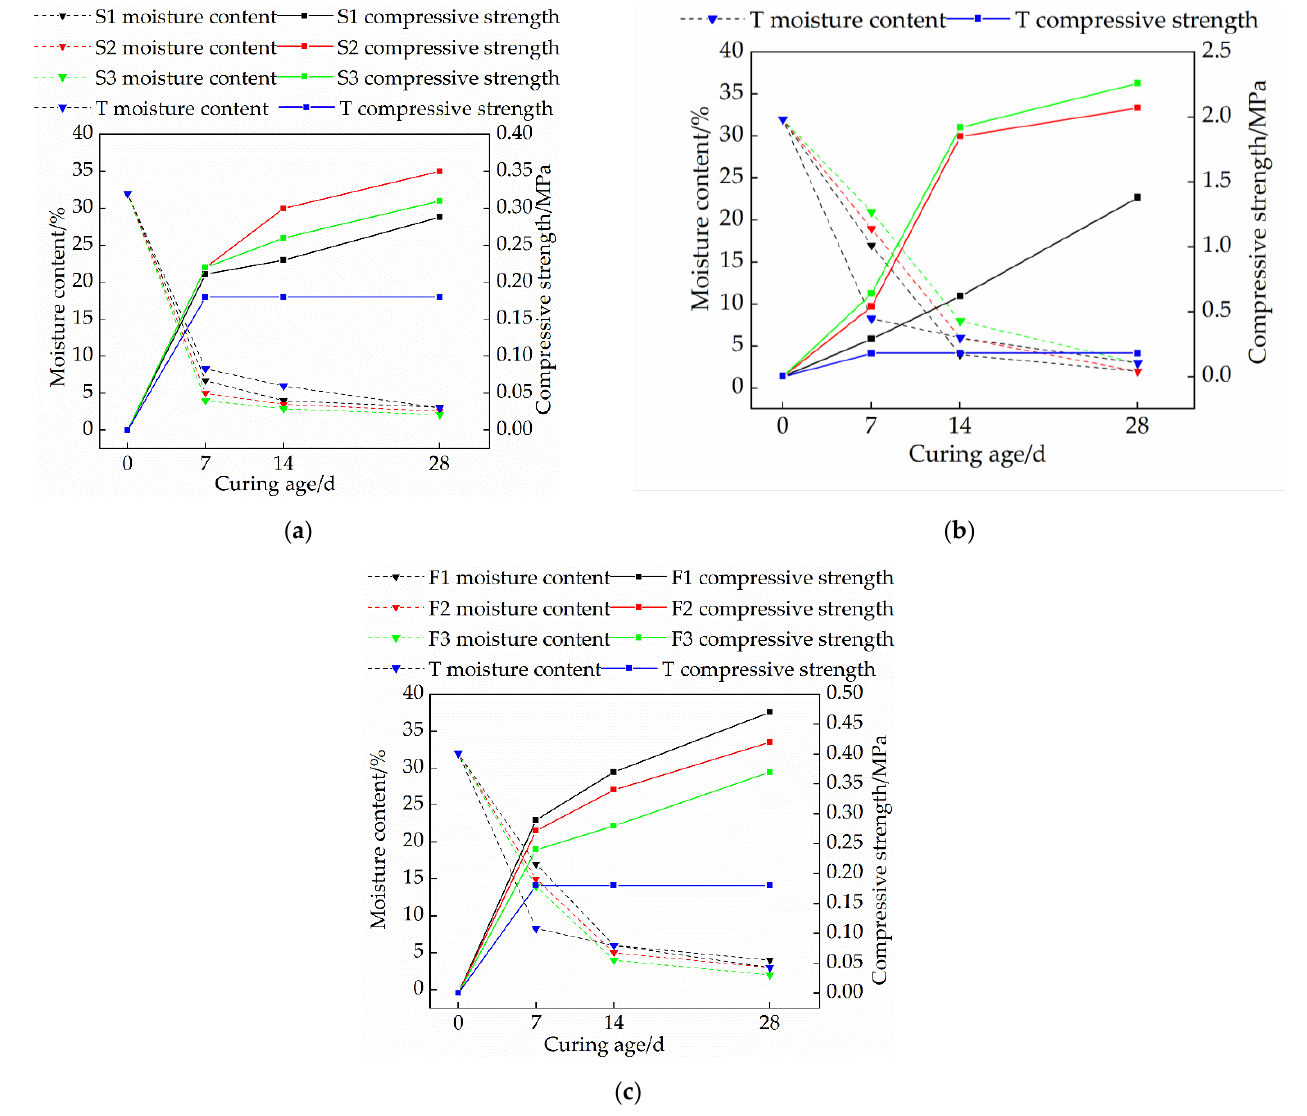
Figure 4. The relationship between the compressive strength and moisture content of each group and the curing age: ( a ) Single mixed quicklime group; ( b ) Mono-doped sodium methyl silicate group; ( c ) Compounding group .